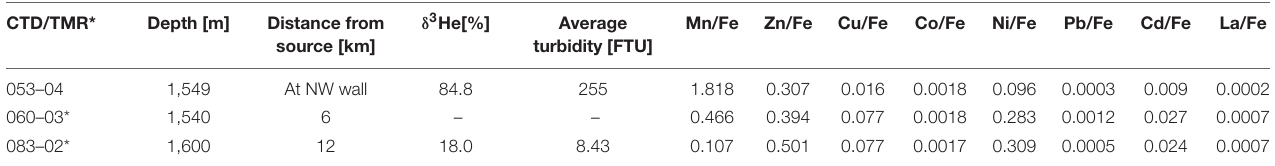
TABLE 2 | Element/Fe ratios [mol/mol] at plume depth ( ∼ 1,550–1,600 m) in vertical CTDs and TMRs taken along a transect within the caldera (CTD 053), toward 6 km (TMR 060) and 12 km to the northwest (TMR 083) outside the caldera of the Brothers volcano.